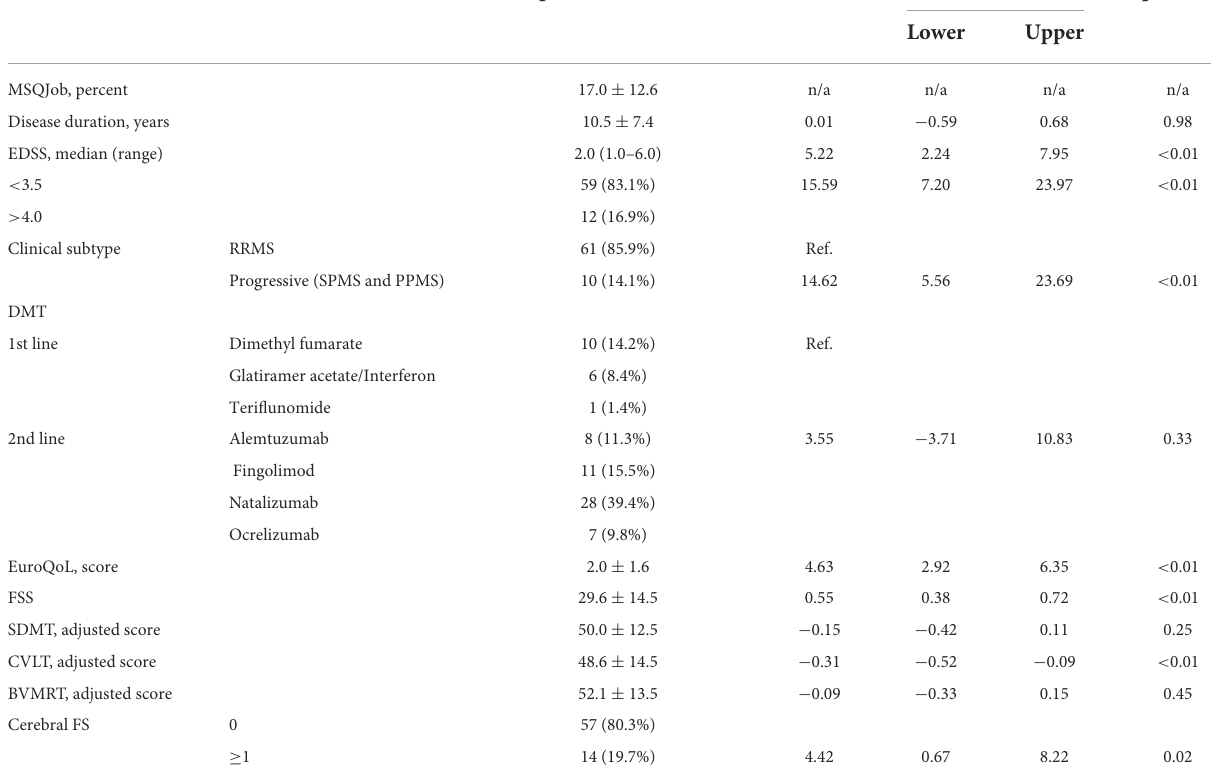
People with MS ( n = 71)